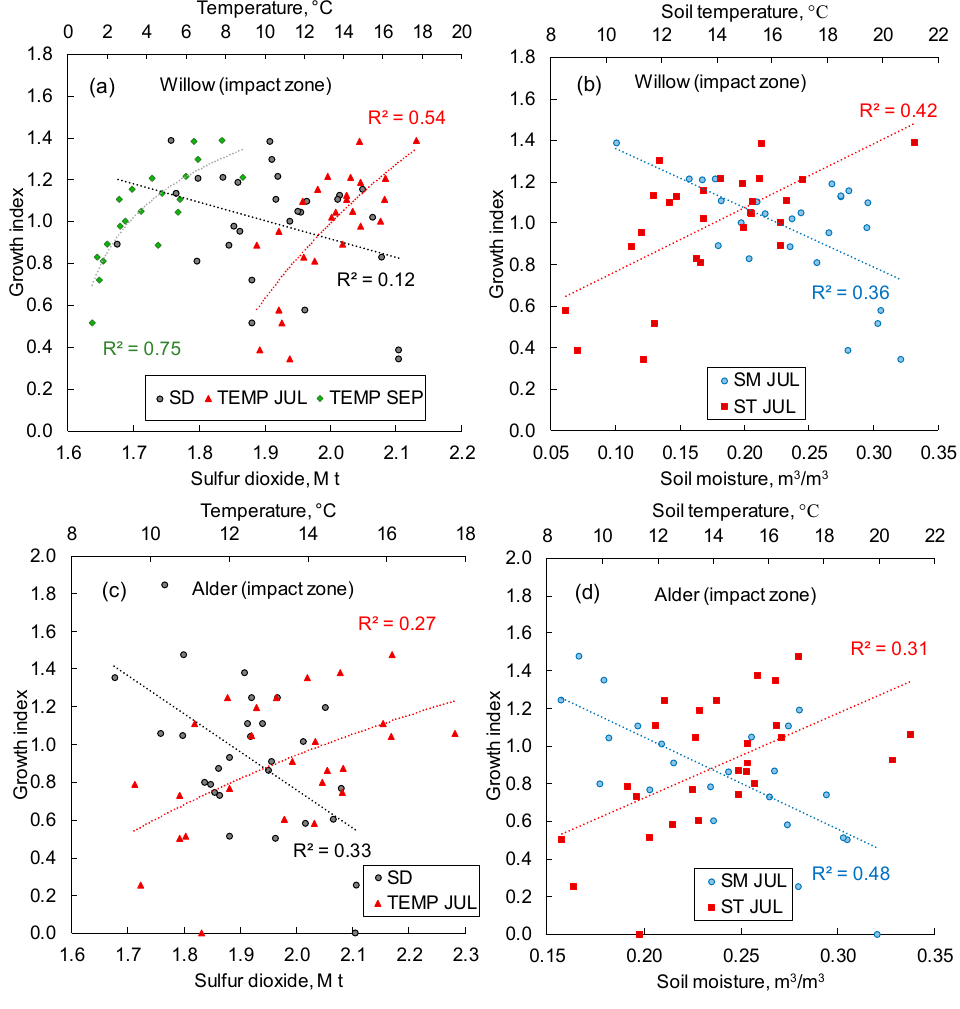
Figure 11. Willow ( a , b ) and alder ( c , d ) growth index correlation with sulfur dioxide emissions, air temperature, soil moisture, and soil temperatures. TEMP and ST—air and soil temperatures, SM—soil moisture, SD—sulfur dioxide emission, JUL—July, SEP—September. The study period is 1993–2021. All trends are significant at p < 0.05 (except for correlations between the GI of willow and SD).